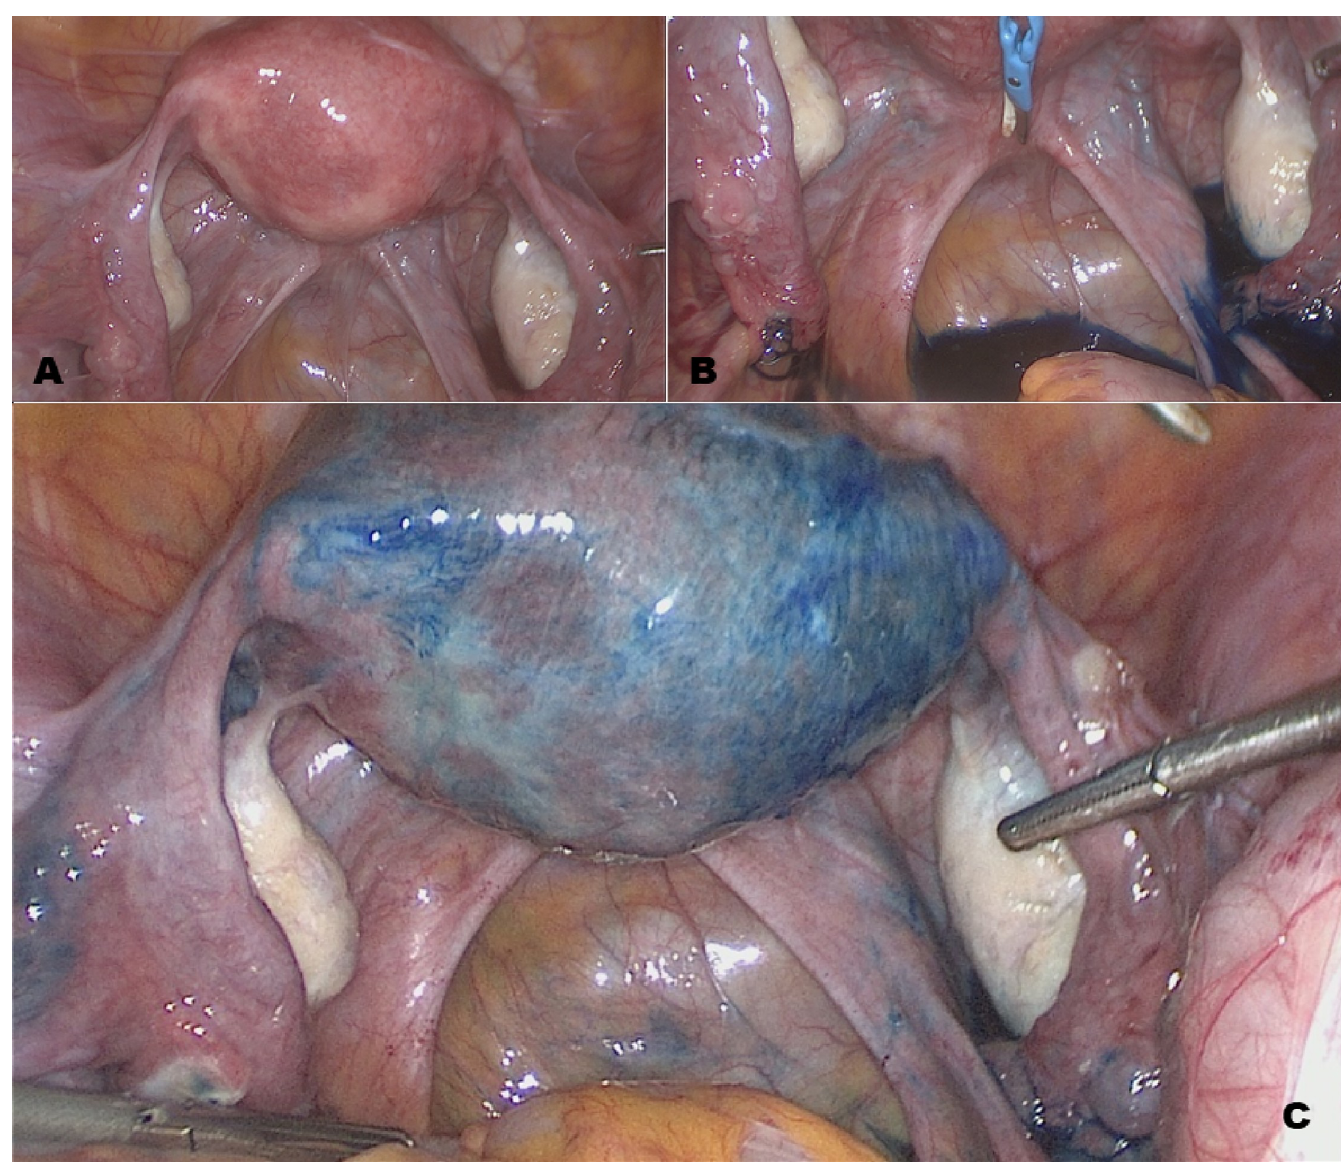
Fig 5. Laparoscopic images. An apparently normal uterus (A) shaded into a peculiar blue color during a methylene blue test in a case of diffuse adenomyosis (C). Bilateral tubal permeability was demonstrated (B).